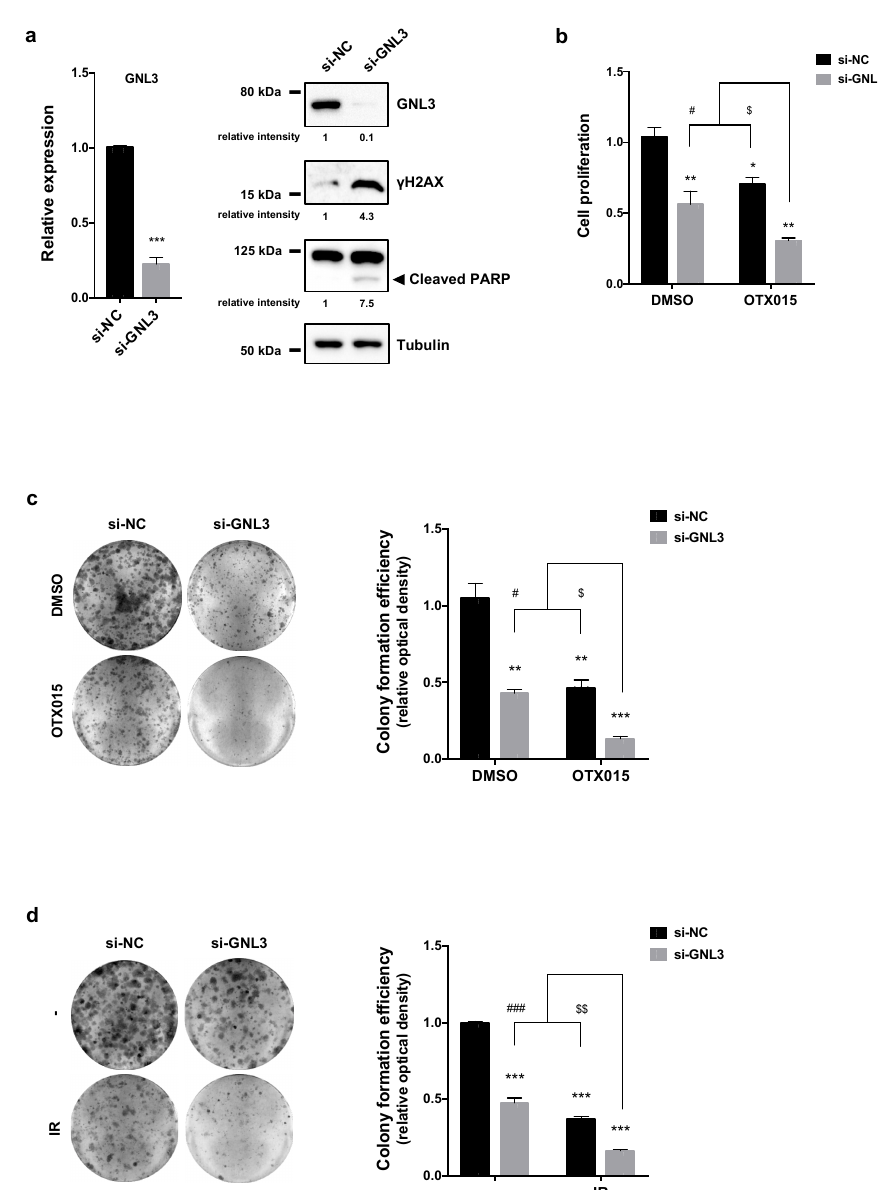
Figure 6. Effects of GNL3 knocking down in OC cells. ( a ) q-PCR analysis (left panel) of GNL3 transcript levels in SKOV3 cells transfected for 72 h with GNL3 siRNAs (si-GNL3), expressed as fold change over mocked control cells (si-NC), set at 1. β -actin mRNA was used as endogenous control. WB analysis (right panel) of GNL3, γ H2AX and PARP proteins performed on SKOV3 cells transfected for 72 h with GNL3 siRNAs (si-GNL3) or negative control molecules (si-NC). Tubulin was used as loading control and representative blot was shown. ( b ) Cell proliferation, evaluated by trypan blue exclusion dye in SKOV3 cells transfected with or without si-GNL3 and exposed to 1 µ M OTX015, was expressed as fold change respect to si-NC/DMSO sample, set at 1. Results represent mean values ± SD of two independent experiments. Statistical significances were calculated by two-way ANOVA: * p < 0.05, ** p < 0.01; *** p < 0.001 vs. si-NC/DMSO; # p < 0.05 vs. si-GNL3/DMSO; $ p < 0.05 vs. si-NC/OTX015. ( c ) Clonogenic assays after 12 days of culture in SKOV3 cells transfected with or without si-GNL3 and treated with 1 µ M OTX015. Representative images of colonies marked with crystal violet and colony formation efficiency obtained by crystal violet absorbance. Experiments were carried out twice, each in triplicate. Histograms are means ± SD. Statistical significances were calculated by two-way ANOVA: ** p < 0.01, *** p < 0.001, vs. si-NC/DMSO; # p < 0.05 vs. si-GNL3/DMSO; $ p < 0.05 vs. si-NC/OTX015. ( d ) Four h after IR, si-NC and si-GNL3 transfected SKOV3 cells were plated at low concentration and cultured for 12 days. Representative images of colonies marked with crystal violet, from two independent experiments, each performed in triplicate. Bar represents the means ± SD of the crystal violet absorbance. Statistical analyses were calculated by using two-way ANOVA: *** p < 0.001, vs. si-NC/no IR; ### p < 0.001 vs. si-GNL3/no IR; $$ p < 0.01 vs. si-NC/IR. The original Western Blot images can be found in Figure